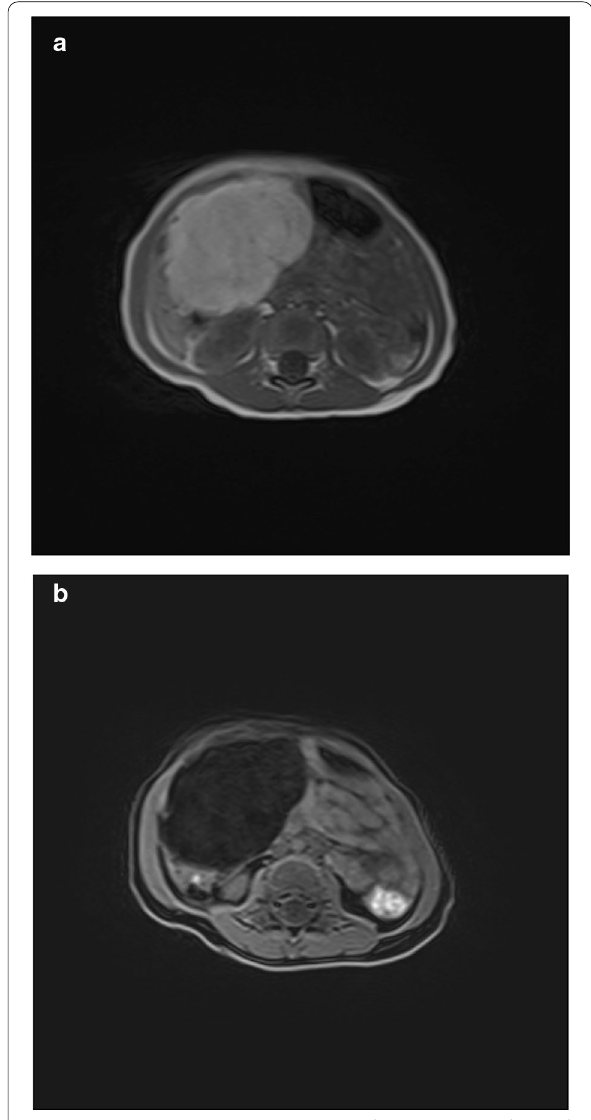
Fig. 2 Magnetic resonance imaging coronal section image obtained a well-encapsulated soft-tissue mass lesion with high intensity in the mesenteric region, a T1-weighted image obtained the mass lesion with high intensity signal. b Fat suppression inversion recovery imaging obtained an interposing fat component showing a reduced